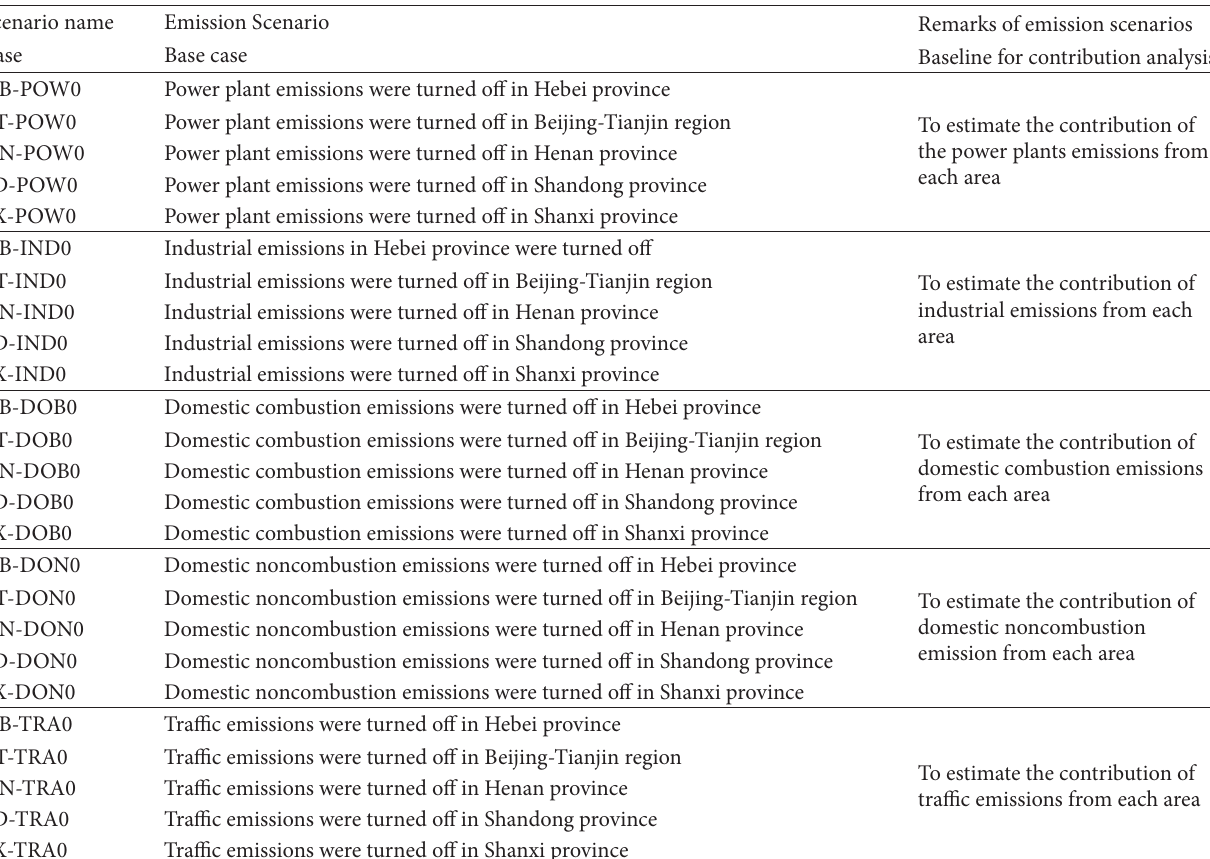
Table 1: Modeling scenarios in this